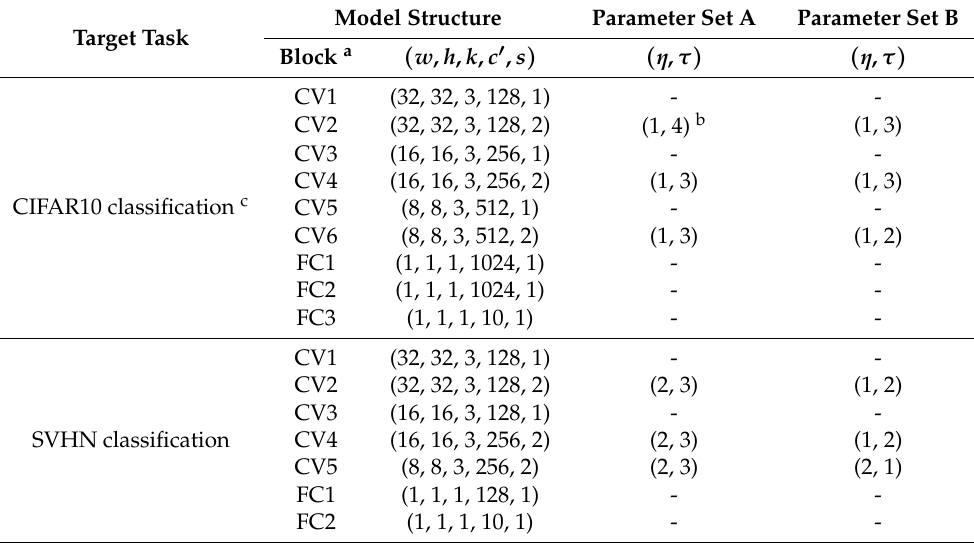
Table 2. BCNN models and the parameters for the proposed operation skipping scheme used for the